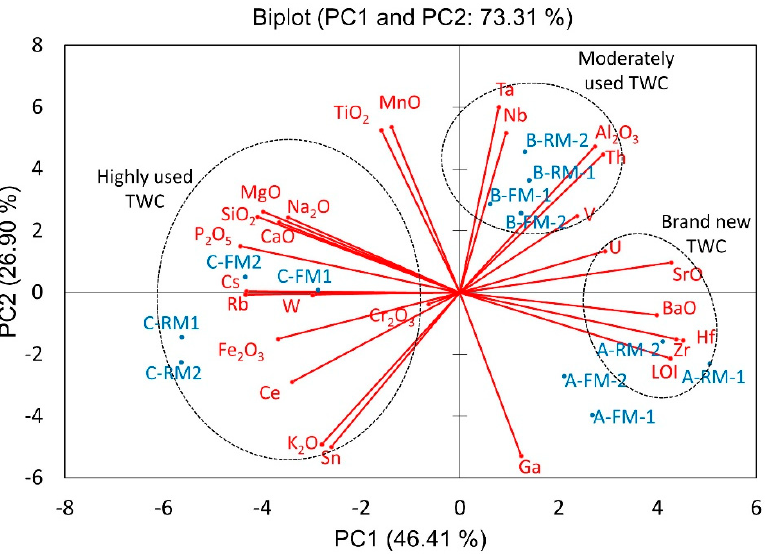
Figure 3. Principal component analysis (PCA) loadings of chemical composition and the studied TWCs. Enclosed ellipses correspond to chemical elements associated with each sample.